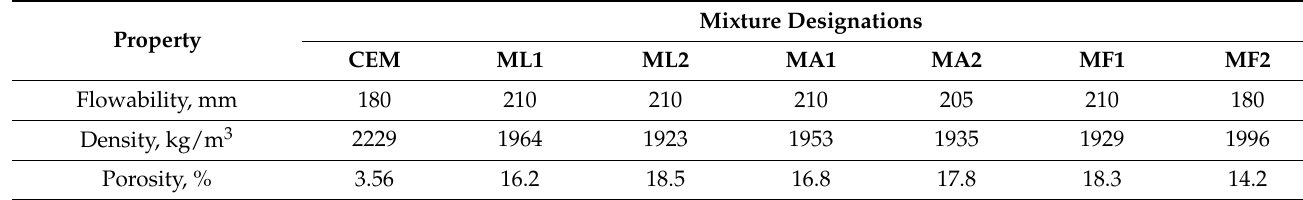
Table 7. The main properties of fresh cement mortars No 2.